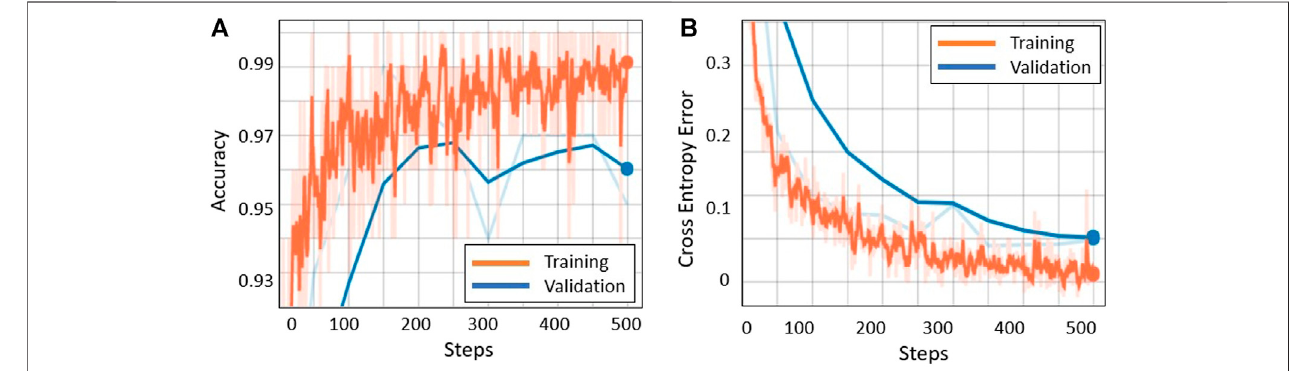
Frontiers in Robotics and AI |